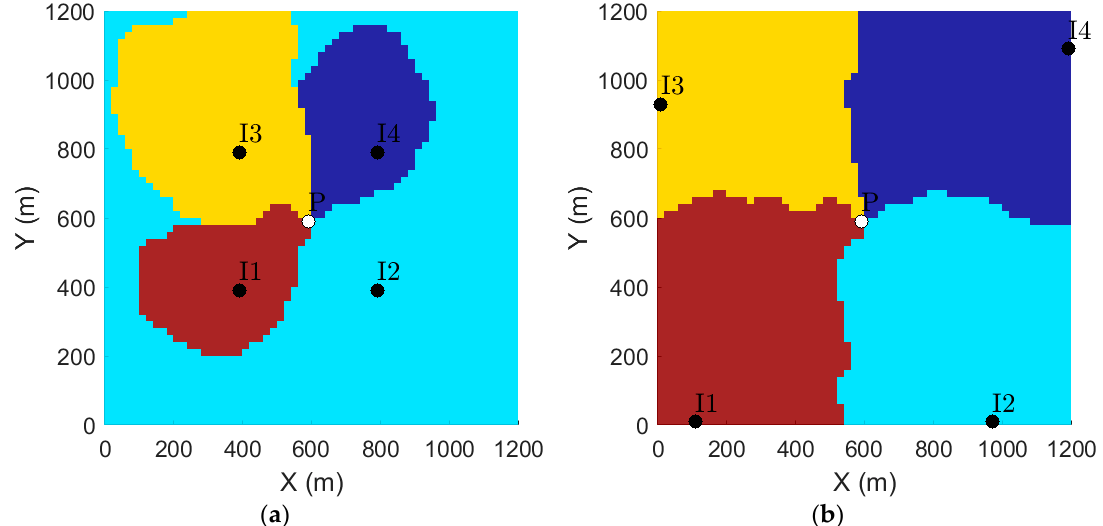
Figure 8. Injection wells capture zones for the ( a ) initial and ( b ) optimal well designs in the two-dimensional heterogeneous aquifer.